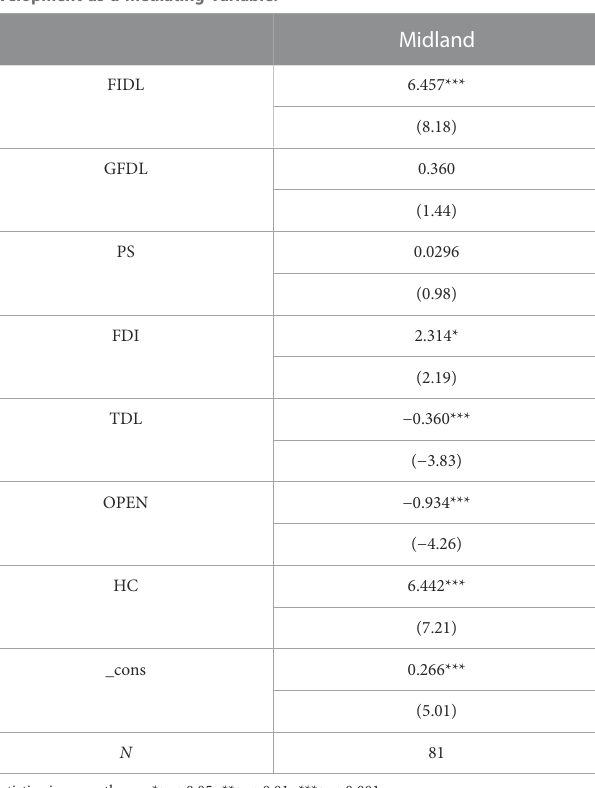
TABLE 13 Regression results for Central Region with fi nancial sector development as a mediating